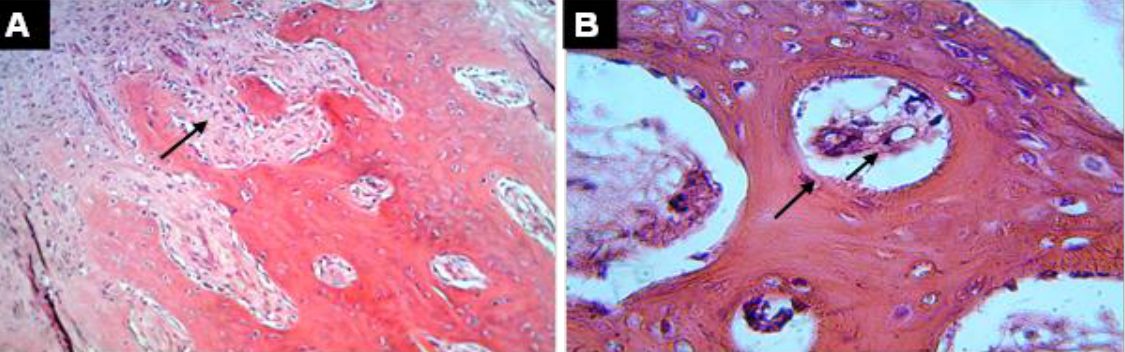
Figure 7. Histopathological section in treated group at 4 th weeks post-operation, (A) Compact bone filled the defect bone (black arrow) and contact with old bone (blue arrow) (B) compact bone and active osteoblasts attachment with old one filled the gap (arrow), (H and E, 400×)